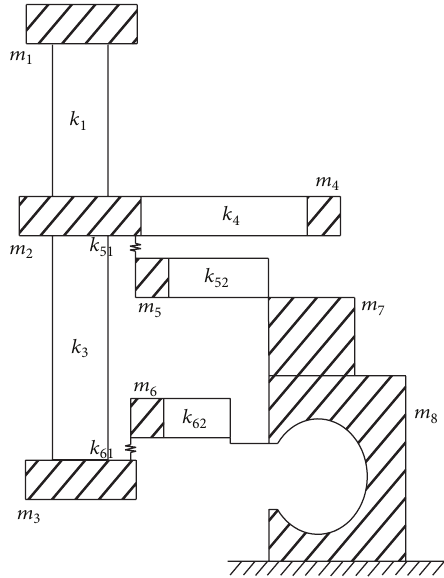
Figure 1: Simplified model of the coupling system between the umbrella unit and the